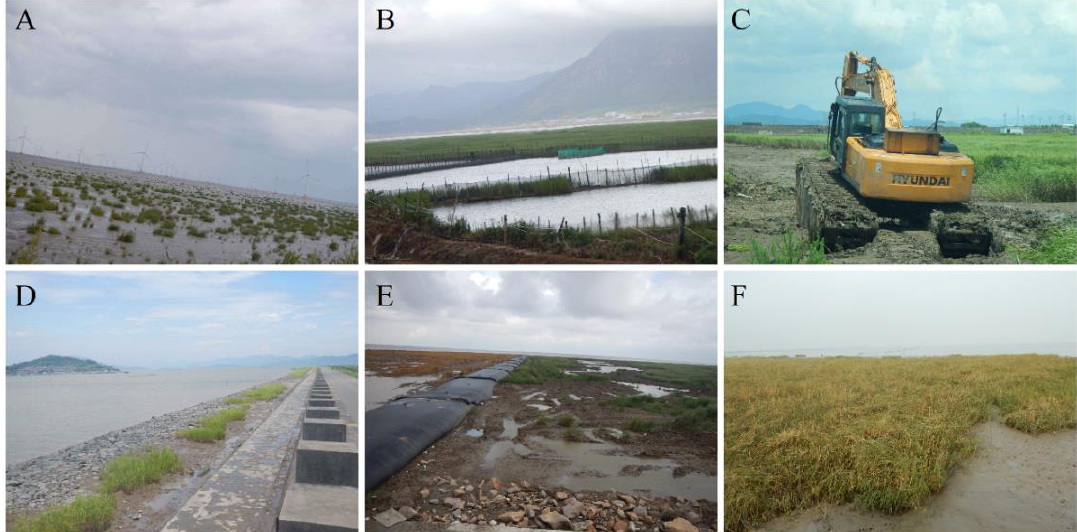
Figure 6. Photos documenting anthropogenic drivers for the expansion and shrinkage of S. alterniflora : ( A ) artificial planting, ( B ) aquaculture development, ( C ) agricultural cultivation, ( D ) dam and road construction, ( E ) herbicide treatment, and ( F ) spikes removal.